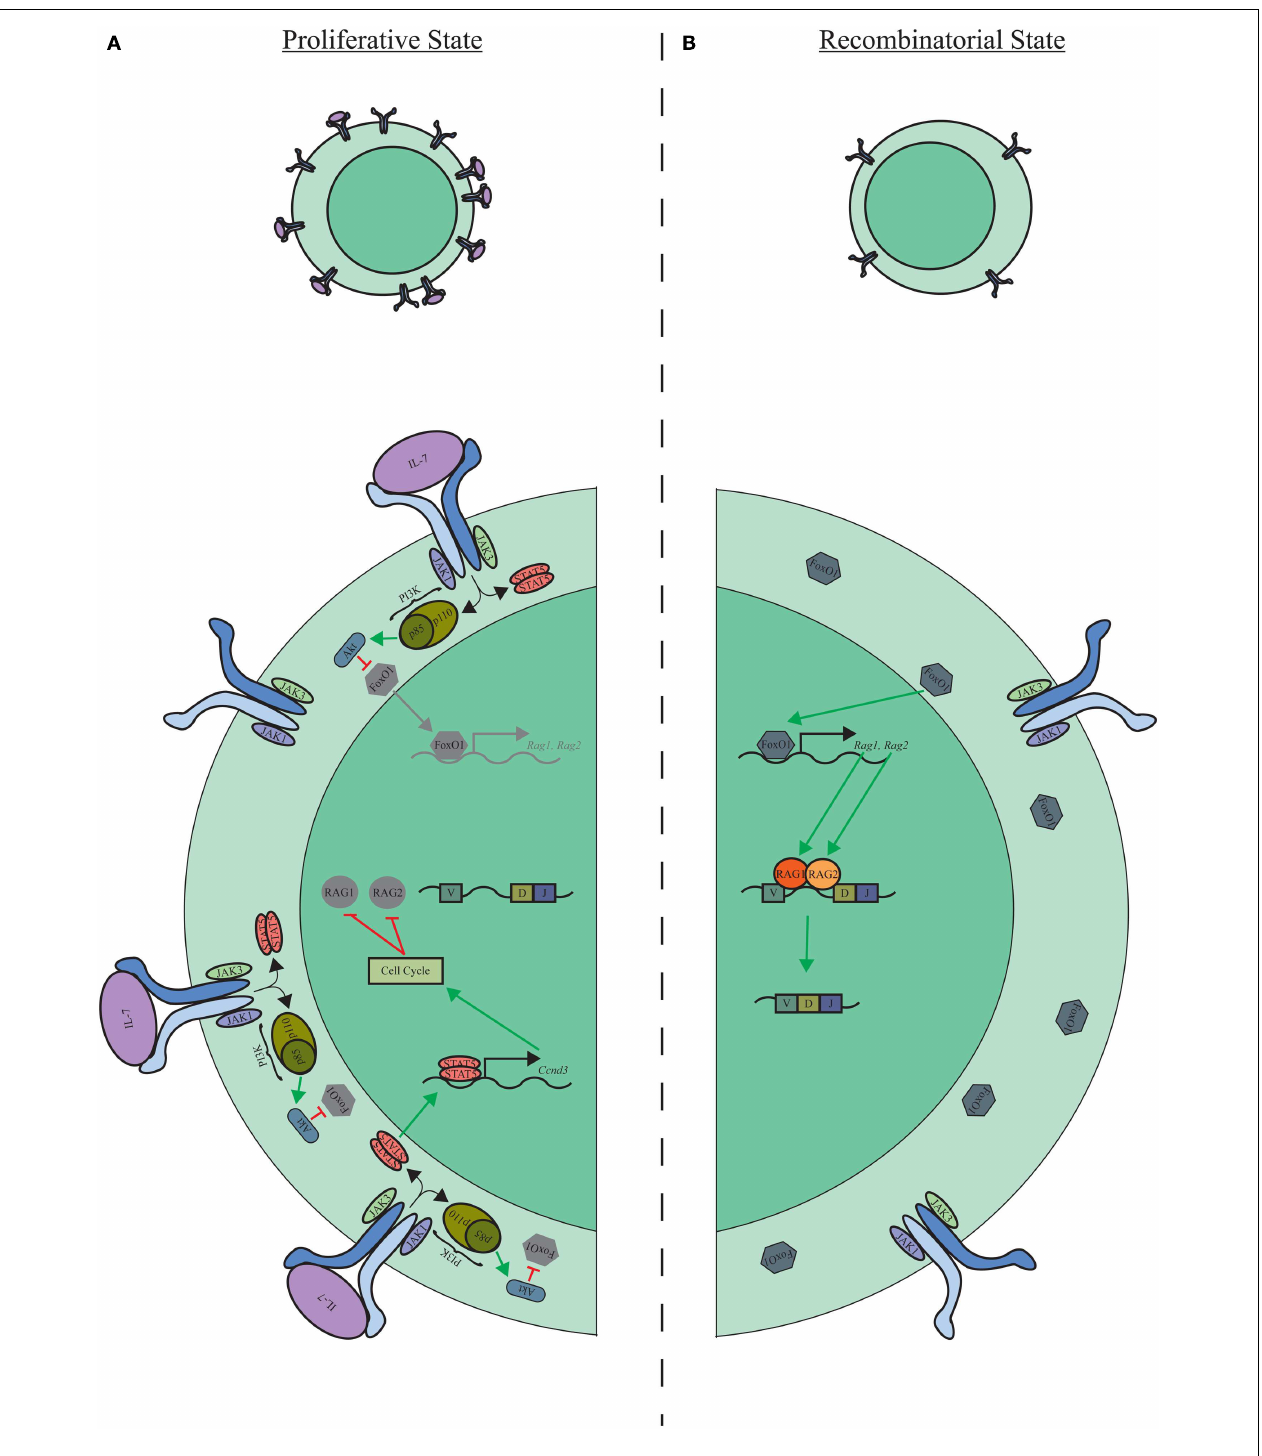
FIGURE 1 | Proliferative and recombinatorial states of pro-B cells . (A) Elevated levels of IL-7R expression and signaling activate STAT5 and PI3K/Akt signaling modules, which enforce the proliferative program of pro-B cells while suppressing Ig µ recombination. (B) Down modulation of the IL-7R is associated with a loss of proliferative signaling through STAT5 and PI3K/Akt and release of FoxO1, Rag-1, and Rag-2 suppression allowing progression of Ig µ recombination.